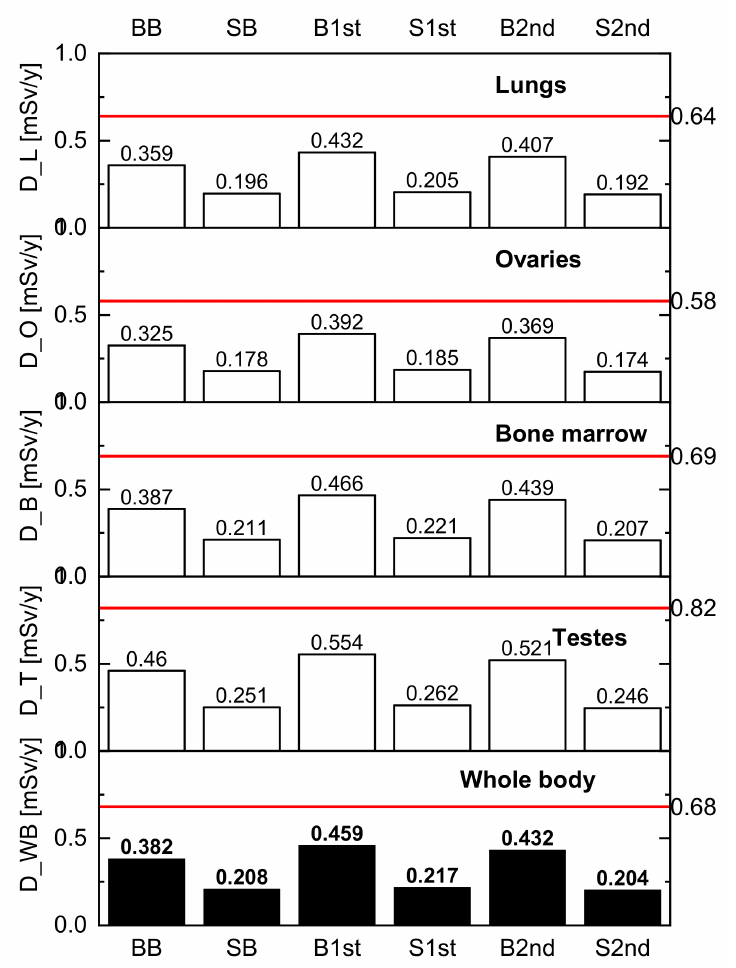
Figure 12. Absorbed dose by different organs and the particular limit values (represented by red